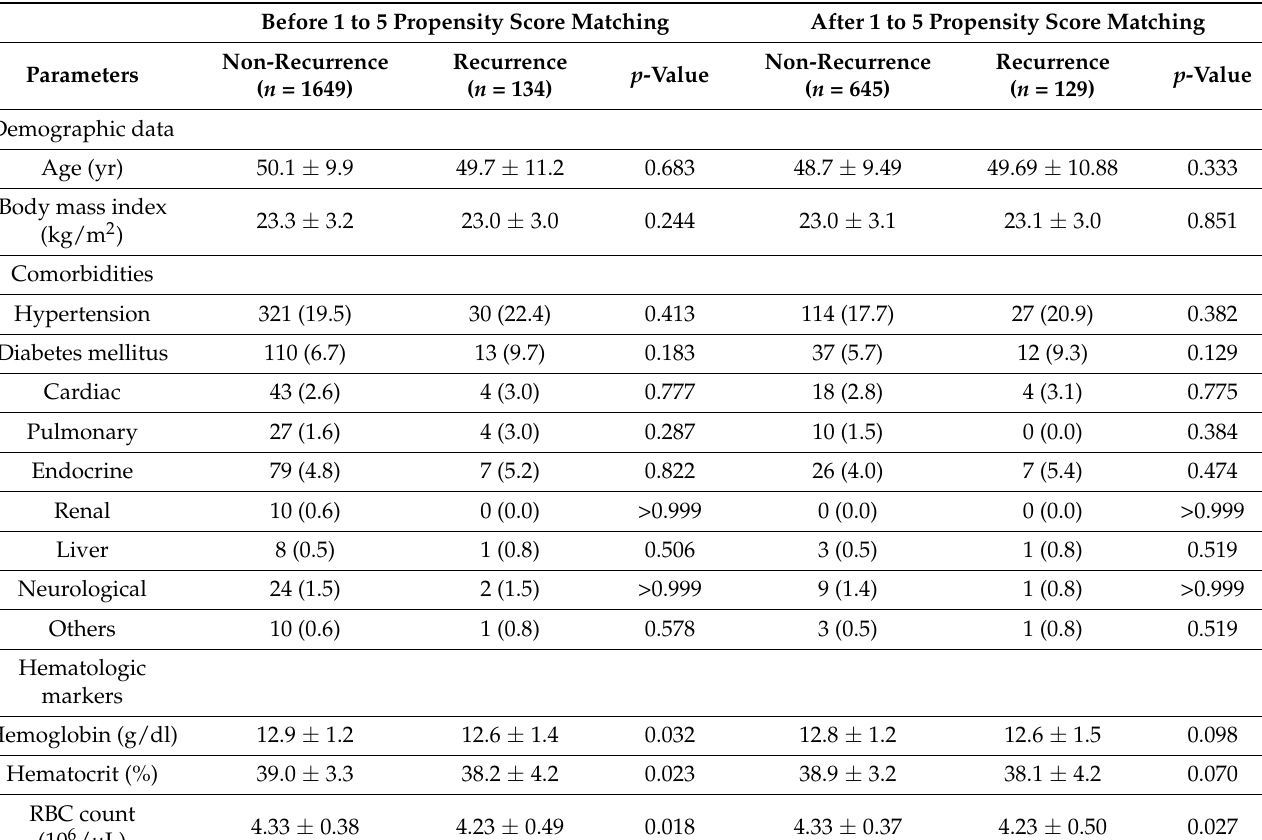
Table 1. Patient characteristics based on postoperative